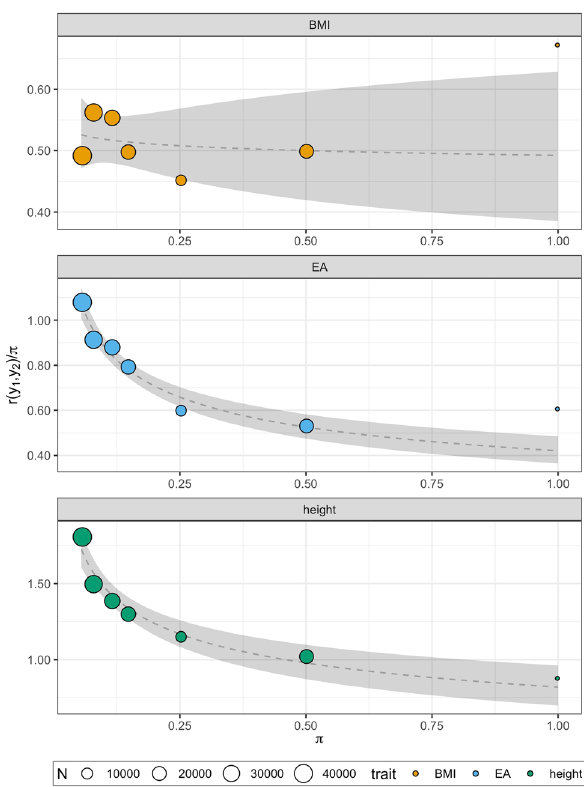
Fig. 3 Modelling of assortative mating in close relatives ( π > 0.05). Traits shown are body mass index (BMI), educational attainment (EA) and height. Points show the phenotypic correlation for close relatives divided by the mean genomic relationship ( π ) and π , where N = number of pairs contributing to each point. The fi tted function is shown with 95% con fi dence intervals ( ± 1 : 96s : e : ) in